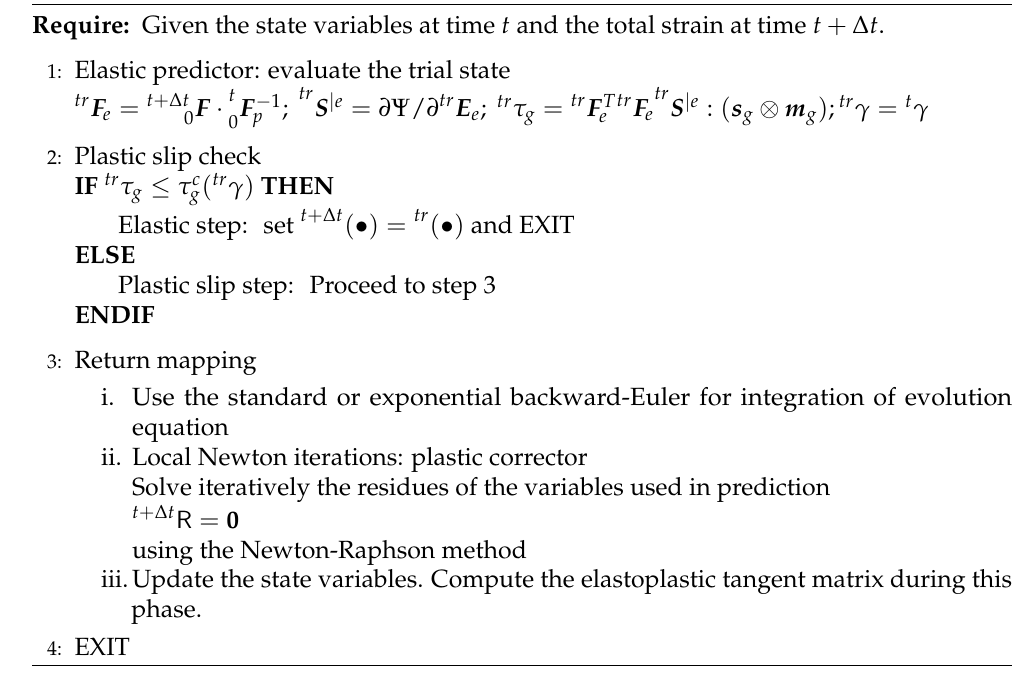
Algorithm 1 Typical structure of an elastic-predictor/plastic-corrector return-mapping